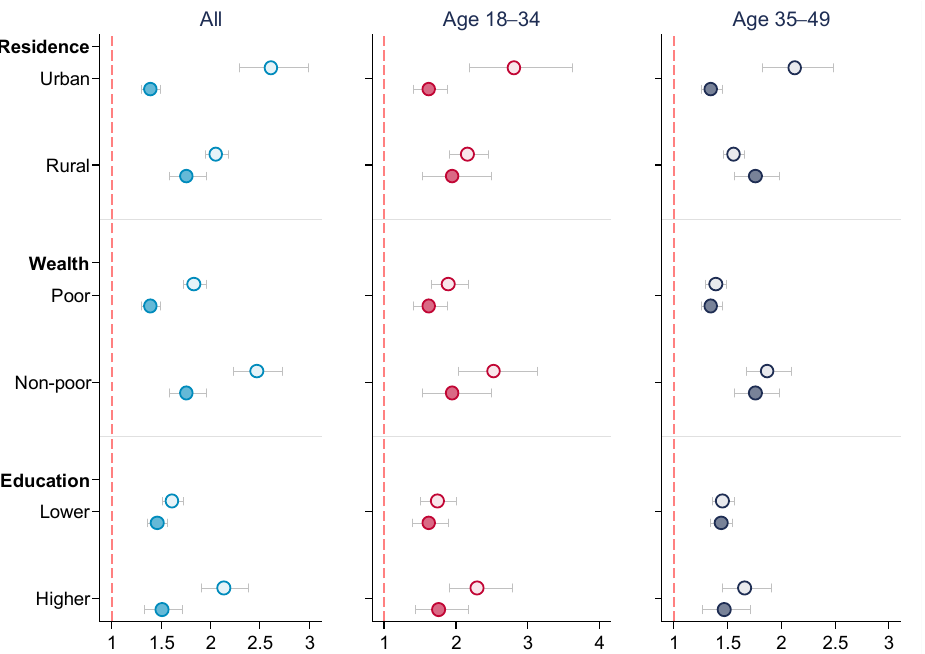
Figure 2. Unadjusted and adjusted odds ratios in favor of tobacco use for marital disruption by residence and SES sub-groups. The lighter markers depict unadjusted odds ratios. The darker markers depict adjusted odds ratios. Estimates were obtained using complex survey weights. Horizontal lines across the markers denote 95% confidence intervals. The multivariable specifications accounted for respondent’s age, educational attainment (for urban/rural and poor/non-poor sub-groups only), wealth index quintiles (for urban/rural and lower-education/higher-education sub-groups only), religion, caste, urban/rural residence (for lower-education/higher-education and poor/non-poor sub-groups only), and geographic region fixed effects.